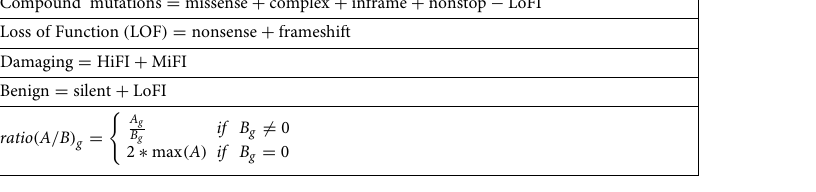
Table 1. Definitions of mutation categories and the ratio of mutation categories. Along with mutation categories annotated by COSMIC, we define additional categories which combine multiple mutation types. These categories together with the 11 mutation categories defined in “Ratio-metric features” section are used to define ratio-metric features. The ratio of two mutation types A and B is defined for a given gene, where A and B are any two mutation categories.